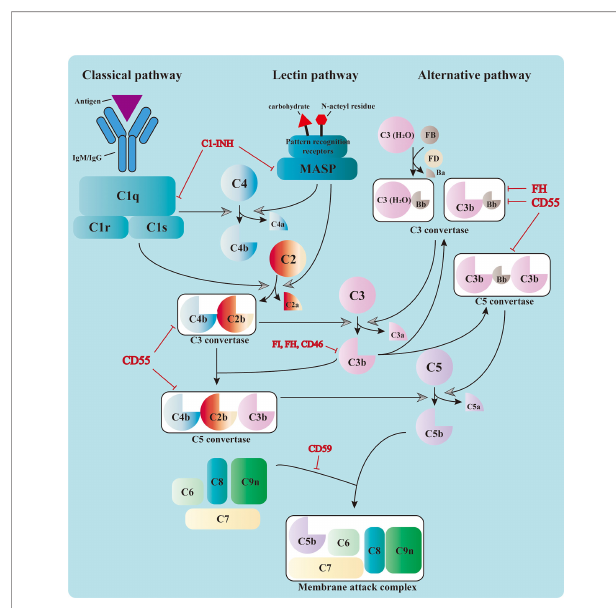
FIGURE 1 | Activation of the complement cascade. The complement system could be triggered by the classical pathway, the lectin pathway, and the alternative pathway. The classical pathway is activated by the binding of C1q to the immunocomplex, which leads to the formation of the C1 complex. The latter cleaves C4 and C2 and assembles the C3 convertase, C4b2b. The serine proteases of the lectin pathway, mannose-binding lectin-associated serine proteases (MASPs), are activated by the recognition of carbohydrate and N -acteyl residues by the pattern recognition receptors. They also cleave